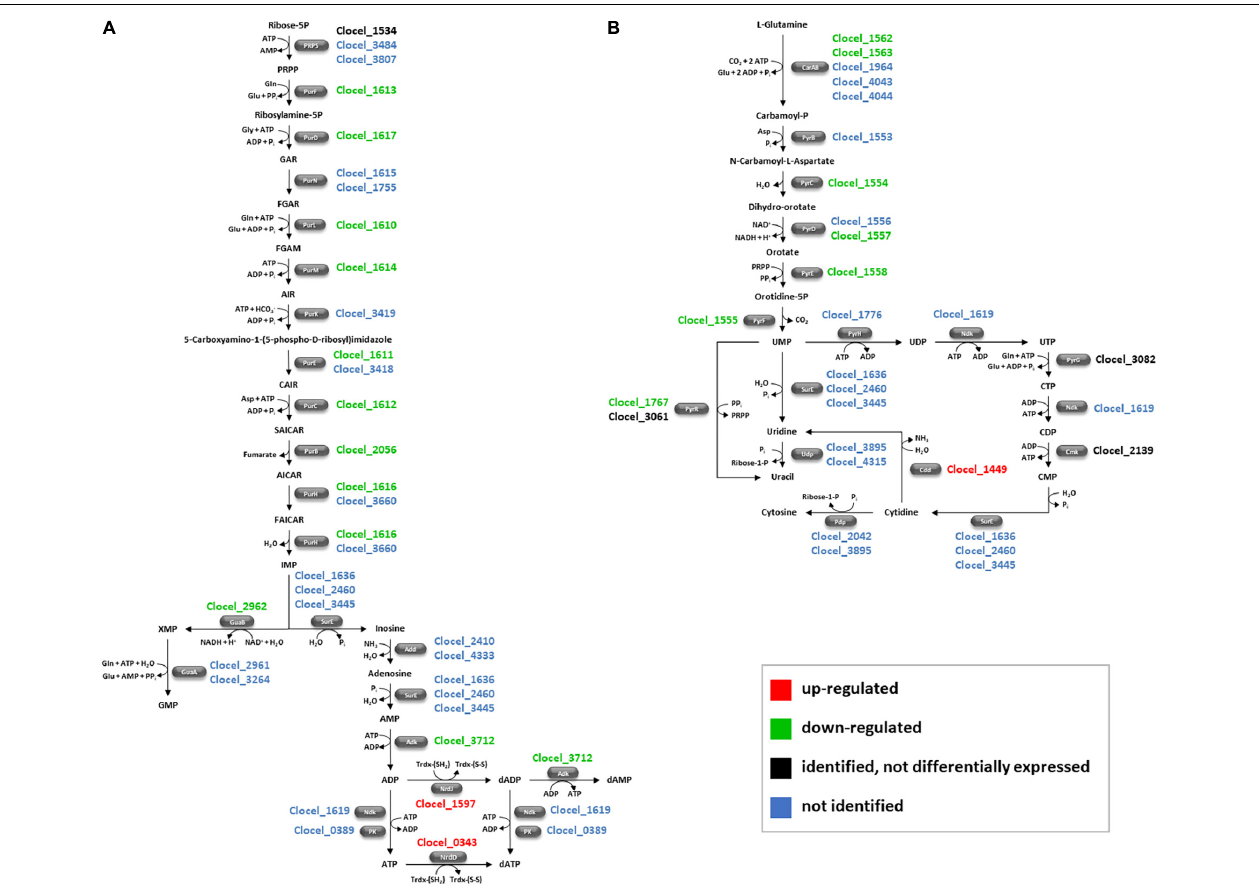
FIGURE 7 | Schematic representation of purine (A) and pyrimidine (B) metabolic pathways of C. cellulovorans . C. cellulovorans genes encoding each pathway enzyme is indicated. Red and green colors were used for gene loci whose protein product was over- or under-expressed in butanol-challenged cells, respectively. Geni loci whose protein product was identified in this study but was in similar amounts in butanol-supplemented and control cultures were indicated in black, while blue indicates geni loci whose protein product was not identified in the present investigation. Add, adenosine deaminase; Adk, adenylate kinase; AICAR, 1-(5 (cid:48) -Phosphoribosyl)-5-amino-4-imidazolecarboxamide; AIR, Aminoimidazole ribotide; CAIR, 1-(5-Phospho- D -ribosyl)-5-amino-4-imidazolecarboxylate; CarA, carbamoyl-phosphate synthase, small subunit; CarB, carbamoyl-phosphate synthase, large subunit; Cdd, cytidine deaminase; Cmk, cytidylate kinase; FAICAR, 1-(5 (cid:48) -Phosphoribosyl)-5-formamido-4-imidazolecarboxamide; FGAM, 2-(Formamido)- N1 -(5 (cid:48) -phosphoribosyl)acetamidine; FGAR, 5 (cid:48) -Phosphoribosyl- N -formylglycinamide; GAR, 5 (cid:48) -Phosphoribosylglycinamide; GuaA, GMP synthase; GuaB, inosine-5 (cid:48) -monophosphate dehydrogenase; IMP, inosine monophosphate; Ndk, nucleoside-diphosphate kinase; NdrD, anaerobic ribonucleoside-triphosphate reductase; NrdJ, ribonucleoside-diphosphate reductase; P i , inorganic phosphate; Pdp, pyrimidine-nucleoside phosphorylase; PK, pyruvate kinase; PRPP, 5-phosphoribosyl 1-pyrophosphate; PRPS, ribose-phosphate pyrophosphokinase; PurB, adenylosuccinate lyase; PurC, phosphoribosylaminoimidazole-succinocarboxamide synthase; PurD, phosphoribosylamine/glycine ligase; PurE, phosphoribosylaminoimidazole carboxylase; PurF, amidophosphoribosyltransferase; PurH, phosphoribosylaminoimidazolecarboxamide formyltransferase/IMP cyclohydrolase; PurK, 5-(carboxyamino)imidazole ribonucleotide synthase; PurL, phosphoribosylformylglycinamidine synthase; PurM, phosphoribosylformylglycinamidine cyclo-ligase; PurN, phosphoribosylamine–glycine ligase; PyrB, aspartate carbamoyltransferase; PyrC, dihydroorotase; PyrD, dihydroorotate dehydrogenase; PyrE, orotate phosphoribosyltransferase; PyrF, orotidine 5 (cid:48) -phosphate decarboxylase; PyrG, CTP synthase; PyrH, uridylate kinase; PyrR, uracil phosphoribosyltransferase; SAICAR, 1-(5 (cid:48)